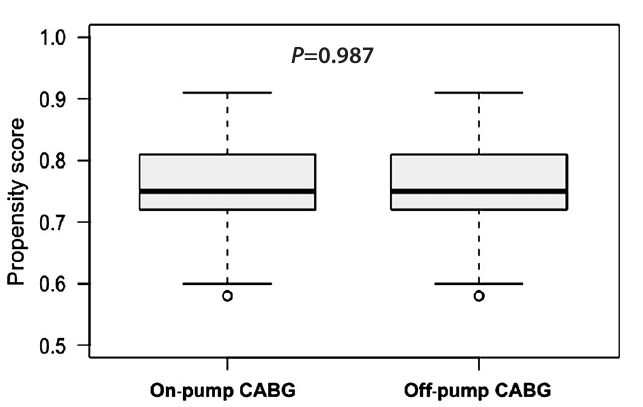
Fig. 1 - Boxplot of the propensity scores of stratified paired study groups. CABG=coronary artery bypass